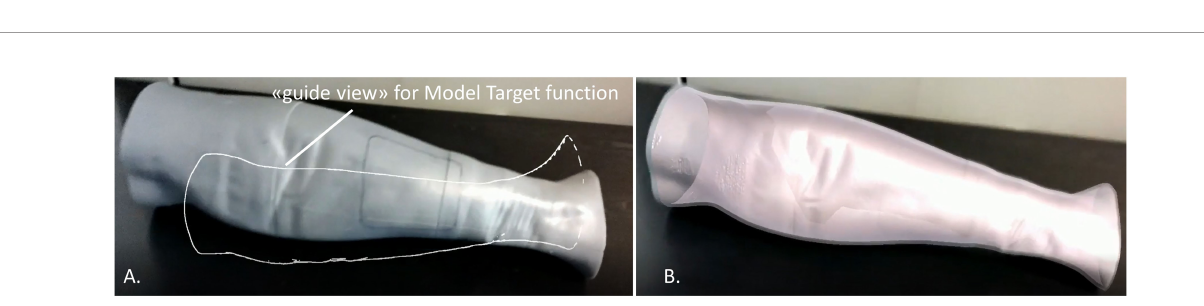
FIGURE 2 | Virtual (A) and 3D printed (B) model of the designed human leg phantom, used for the experimental phase.